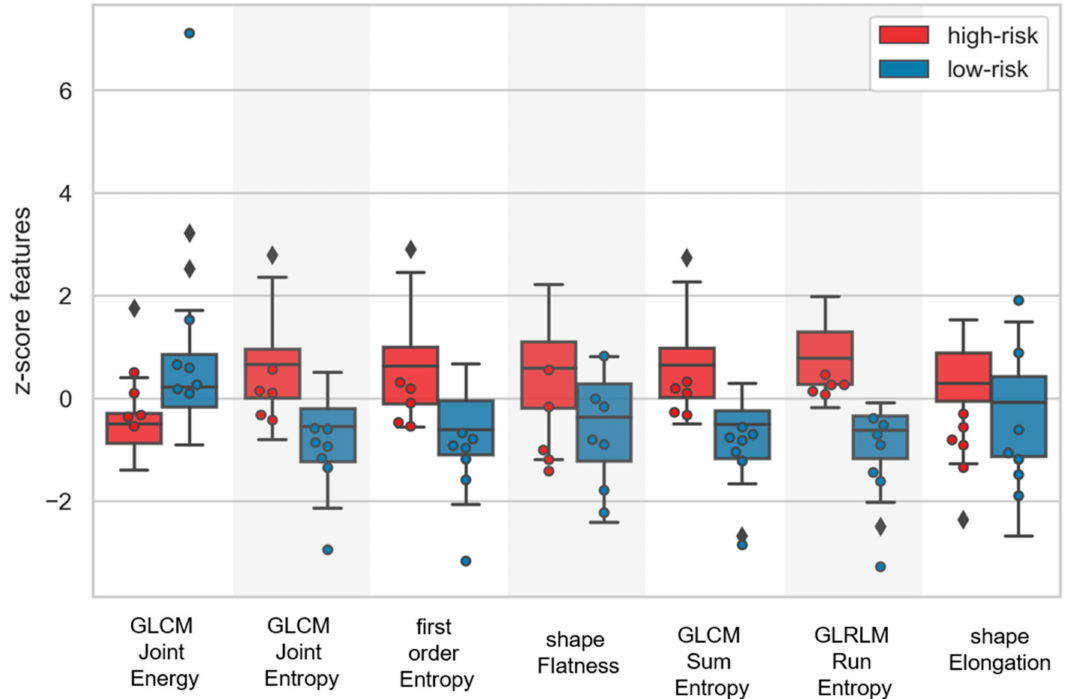
Figure 1. Standardized dose features for patients as stratified by the best performing r-Cox model (i.e., highest validation C-index) according to the risk (high in red, low in blue) of showing an adverse local control. The model was re-trained on the whole training set (80% dataset), from which the stratification cut-off was estimated, and tested on the hold-out test set (20% dataset). Boxplots refer to re-training data, whereas the overlaid points refer to test